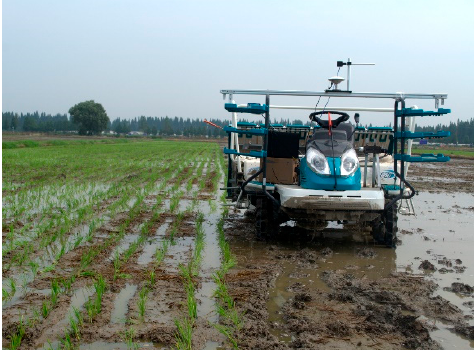
Figure 8. Field experiment of automatic navigation operation.